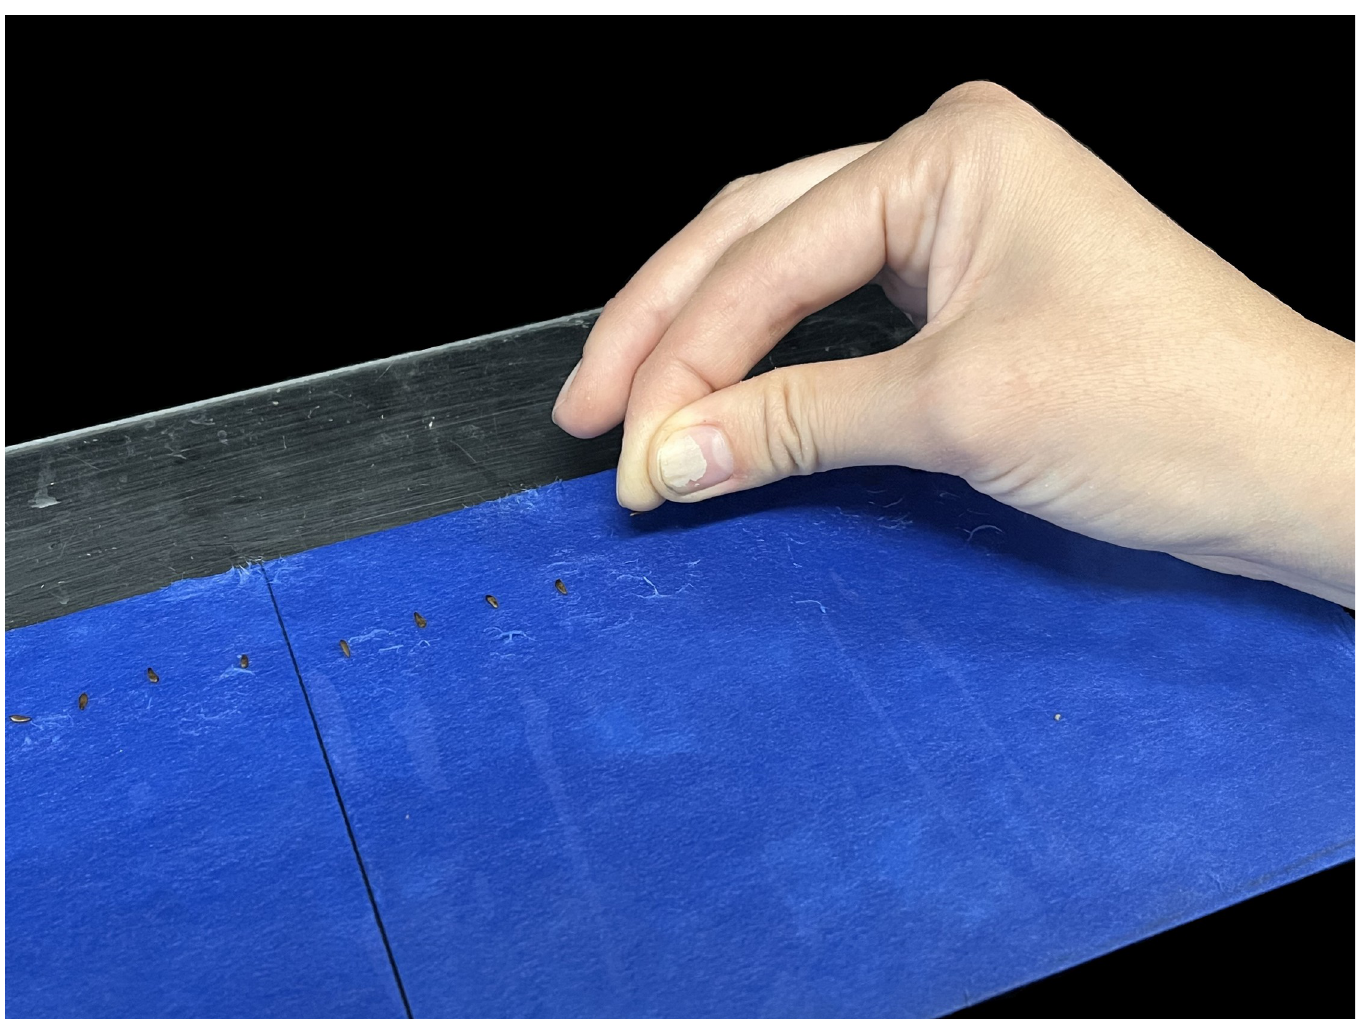
Fig 2. Planting of lettuce ( Latuca sativa ) seeds on blue germination blotter paper.